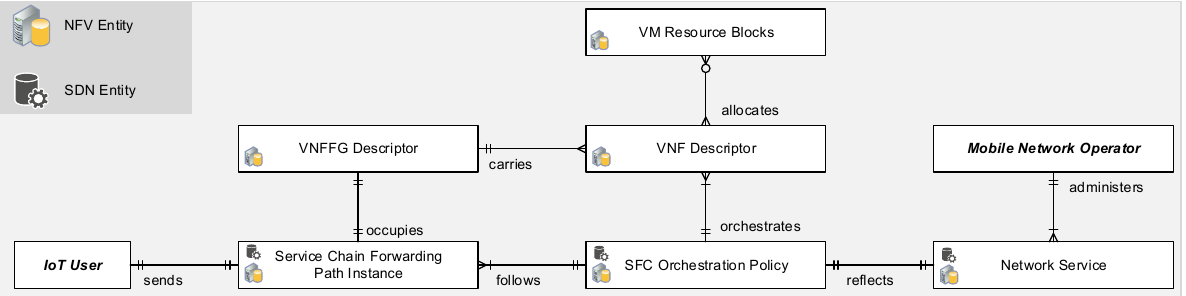
Figure 2. The entity relationship diagram of the system SDN/NFV-enabled SFC.